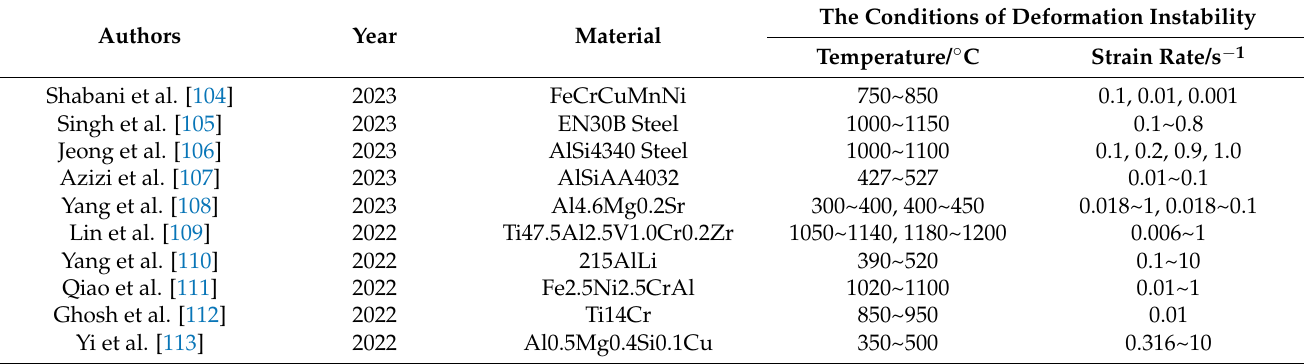
Table 3. Summary of the latest research on deformation instability in hot